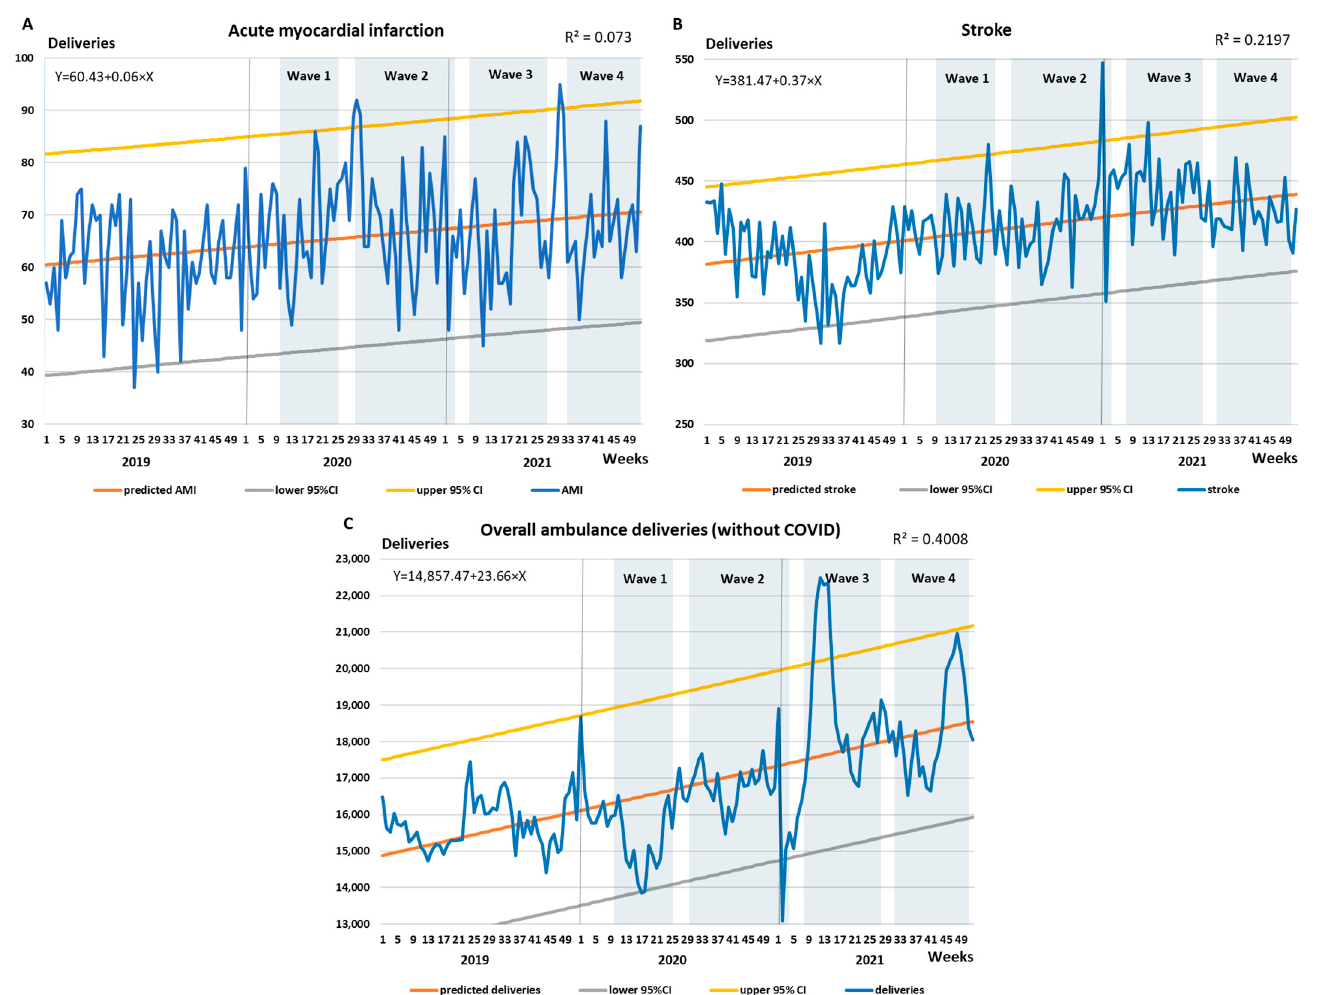
Figure 1. Weekly average of ( A ) acute myocardial infarction, ( B ) stroke, and ( C ) overall non-COVID- related deliveries by the NAS between 2019 and 2021. The upper and lower 95% confidence intervals are calculated based on the predicted values. The R-squared values of the linear trends are shown in the upper-right corners, and the equations of the regression lines are shown in the upper-left corners. Figure 2A,B illustrate the weekly moving average of COVID-19 screenings and is consistent with the COVID-19 waves. In terms of acute myocardial infarction, the gender and age distribution did not change significantly over a three-year period (see Supple- mentary Material Table S1). For haemorrhagic stroke, only the age distribution changed significantly ( p = 0.045) between 2019 and 2020, and for ischemic stroke a significant differ- ence was observed with respect to age between 2019 and 2021 ( p = 0.016). After merging the two types of strokes, the significant difference persisted for age when comparing 2019 and 2020 data ( p = 0.015) and when comparing 2019 and 2021 data ( p = 0.006). For all non-COVID-19-related deliveries, the distribution for both gender and age was significant across all three years ( p <